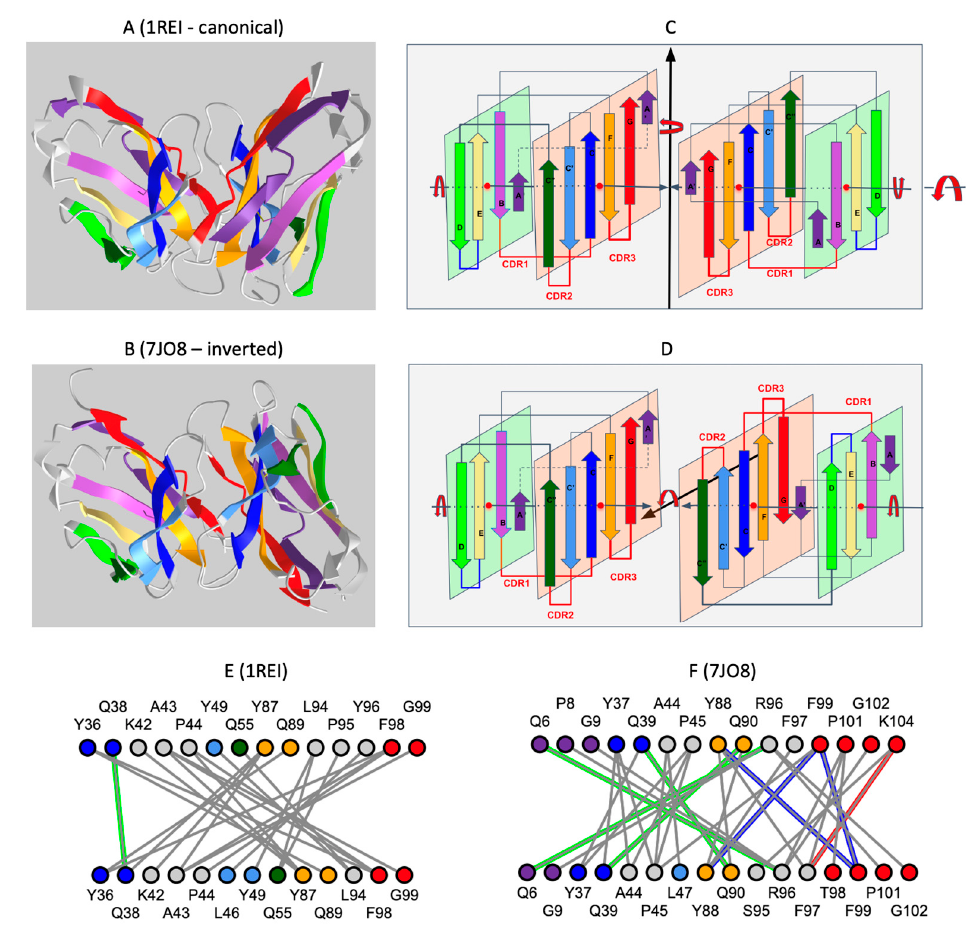
Figure 3. Comparison of the inverted VL-VL dimer vs. the Bence-Jones VL-VL dimer. ( A ) Canonical dimer interface using the GFCC’ sheet observed in the Bence-Jones protein (1REI): The observed quaternary axis of symmetry is vertical. This is the classical interface of antibody VH-VL domains with the CDRs on the same side. It is also found in the Bence-Jones protein as a VL-VL: 3D visualization of the Bence-Jones protein with a canonical interface iCn3D-1REI homodimer (VL-VL): https:// structure.ncbi.nlm.nih.gov/icn3d/share.html?RK2mWw4w3BfULb2H6, (accessed on 19 April 2023). ( B ) Inverted dimer interface using the GFCC’ sheet observed in the CAR VL-VL dimer (7JO8): The observed quaternary axis of symmetry is horizontal coming out of the page plane. It corresponds to a flip (180 degrees rotation) of one VL domain vs. the other. In this case, CDRs are on opposite sides; the C terminus G strands are pointed in opposite directions. The figure shows the structure of a VL-VL dimer interacting through the GFCC’ sheet in antiparallel iCn3D-7JO8 inverted homodimer: https: //structure.ncbi.nlm.nih.gov/icn3d/share.html?eGmk1SeSjLyok3p37, (accessed on 19 April 2023). The second row ( C , D ) represents a schematic representation of the variable domains in both dimers. The third row ( E , F ) compares the interactions between the GFCC’C” sheet between the two dimers. The Bence-Jones protein symmetric dimer interface is similar to a canonical pseudosymmetric VH-VL interface, forming in particular H-bonds between residues Q38 in symmetric positions. The inverted VL-VL dimer interface forms a tighter symmetric interface with 4 residues forming H-bonds (green) (Q6-R96 Q39-Q90), aromatic interactions (blue) (Y88-F99, F99-F99), and aromatic cation interaction (red) (F97-K104). See 3D visualization: comparison of the two VLVL dimer interfaces: https:// structure.ncbi.nlm.nih.gov/icn3d/share.html?EqpkRWuB1bCaBXTc9, (accessed on 19 April 2023). Coloring of Ig strands using the full rainbow spectrum (iCn3D: strands A/A (cid:48) : dark violet, strand B: light violet, strand C: dark blue, strand C (cid:48) : light blue, strand C (cid:48)(cid:48) : dark green, strand D light green, strand E: yellow, strand F: orange, strand G: red. Loops in